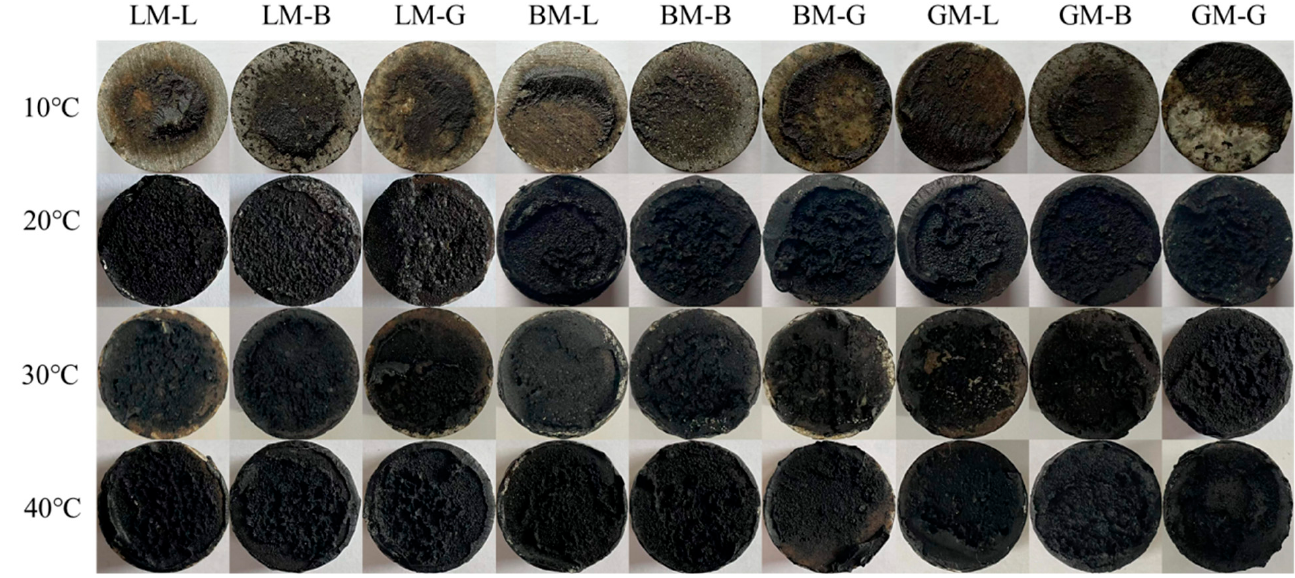
Figure 10. Bond strengths of asphalt mastic–aggregate interfaces at different temperatures.